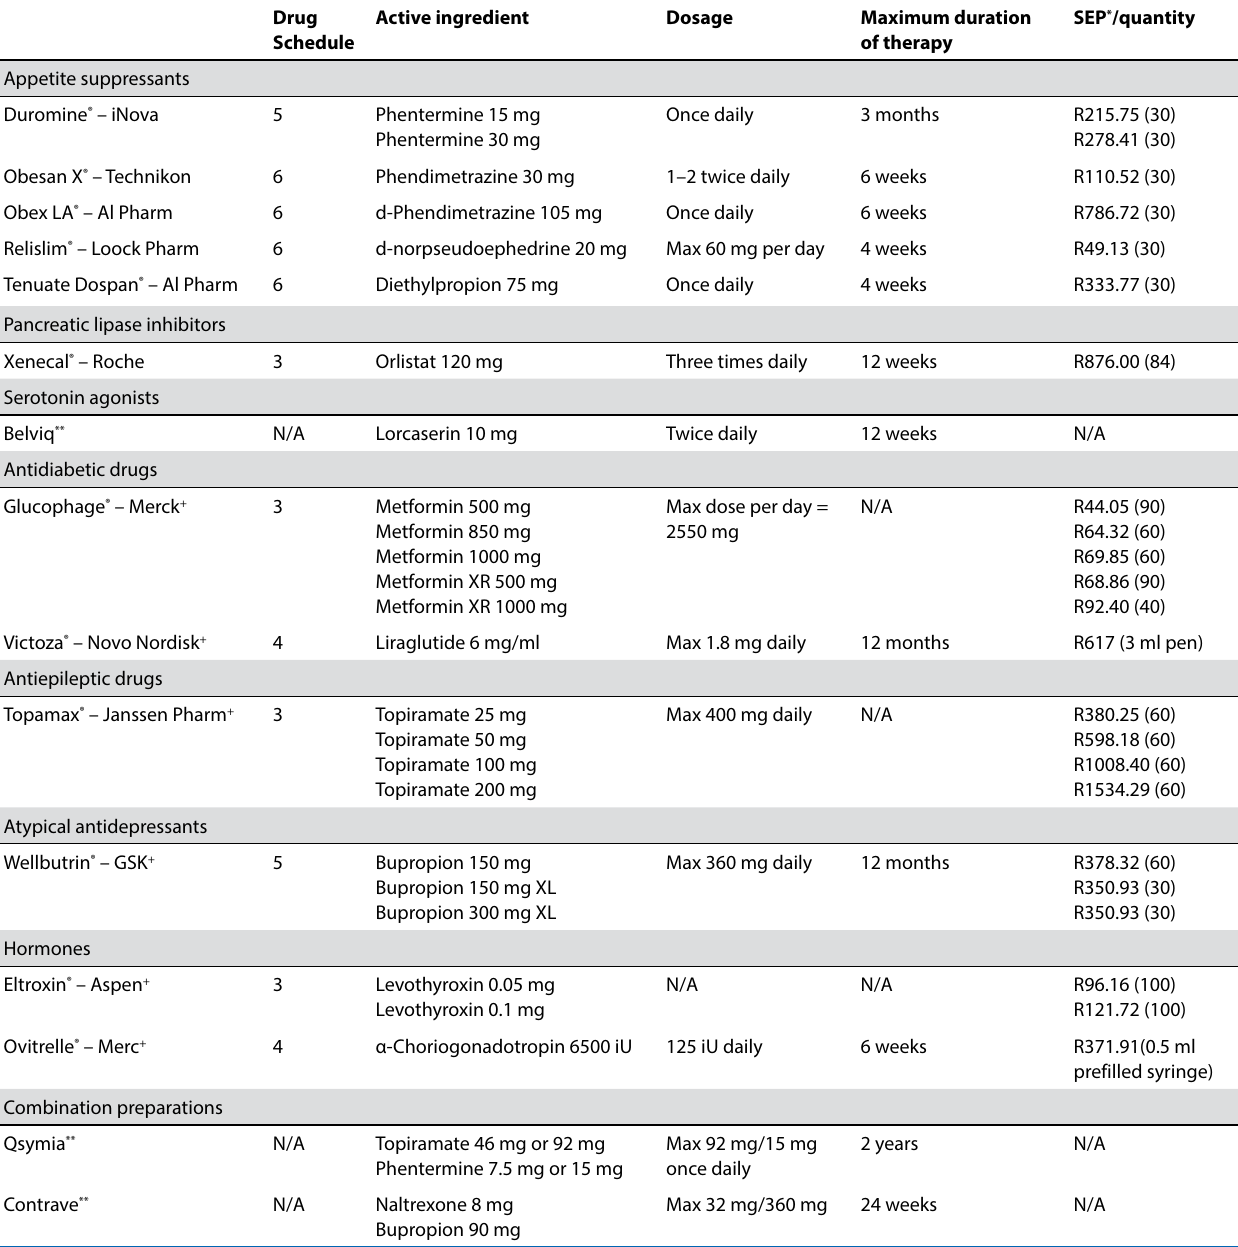
Table I. Available agents in the management of obesity